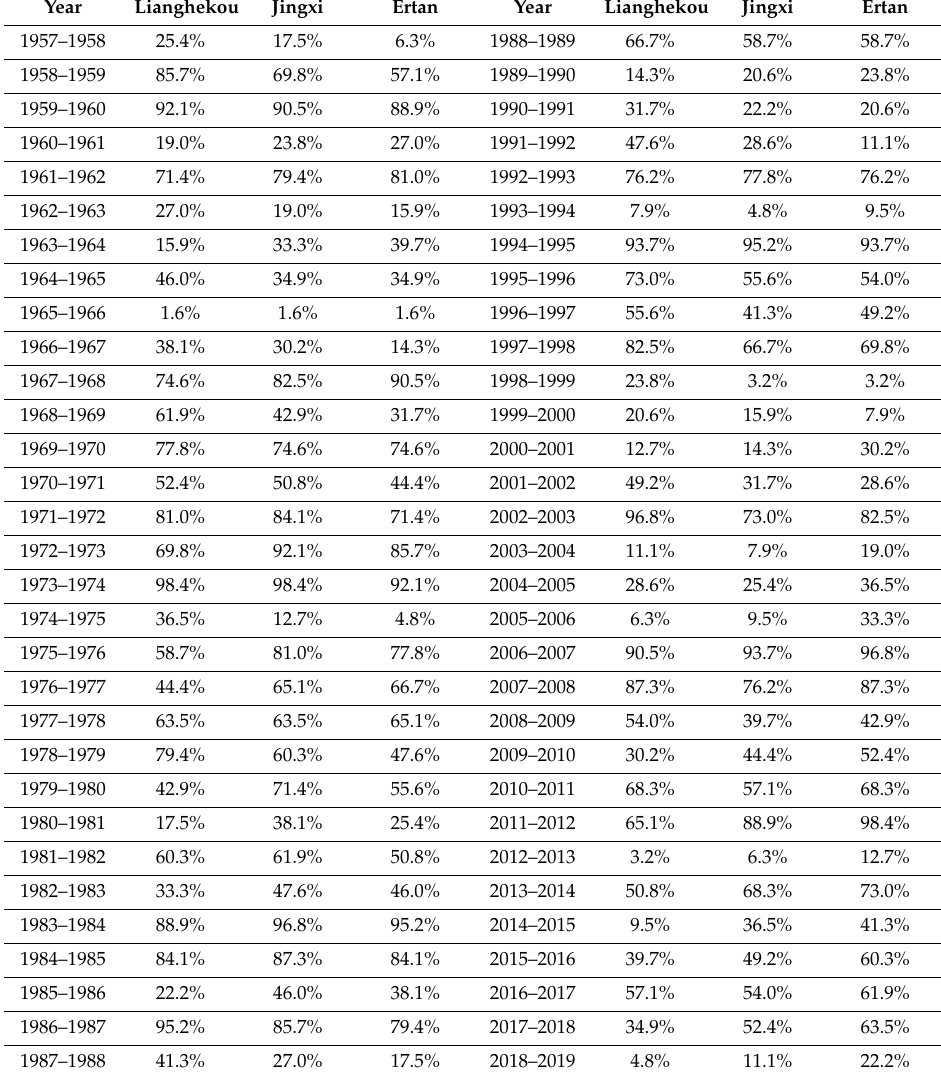
Table 2. Inflow frequency of each station in each hydrological